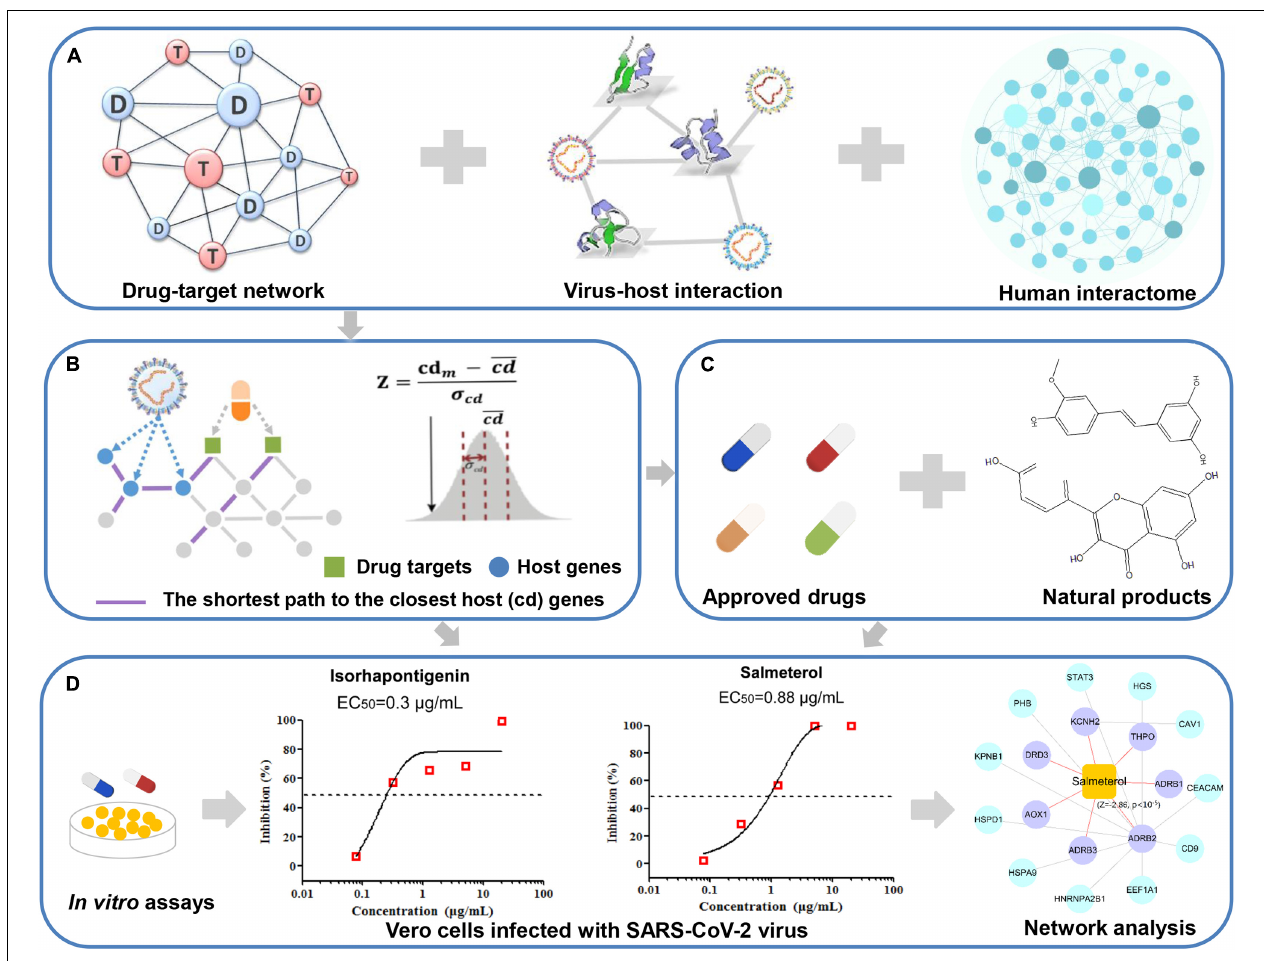
FIGURE 1 | A schematic diagram illustrating network methodology and validation for in silico prediction of drug candidates against COVID-19. Integration of the drug–target network, virus–host interaction, and human interactome (A) . Network proximity approaches (B) . In silico prediction of drug candidates including approved drugs and natural products (C) . In vitro validation of potential candidates and network analysis inferring the mechanism of action (D)